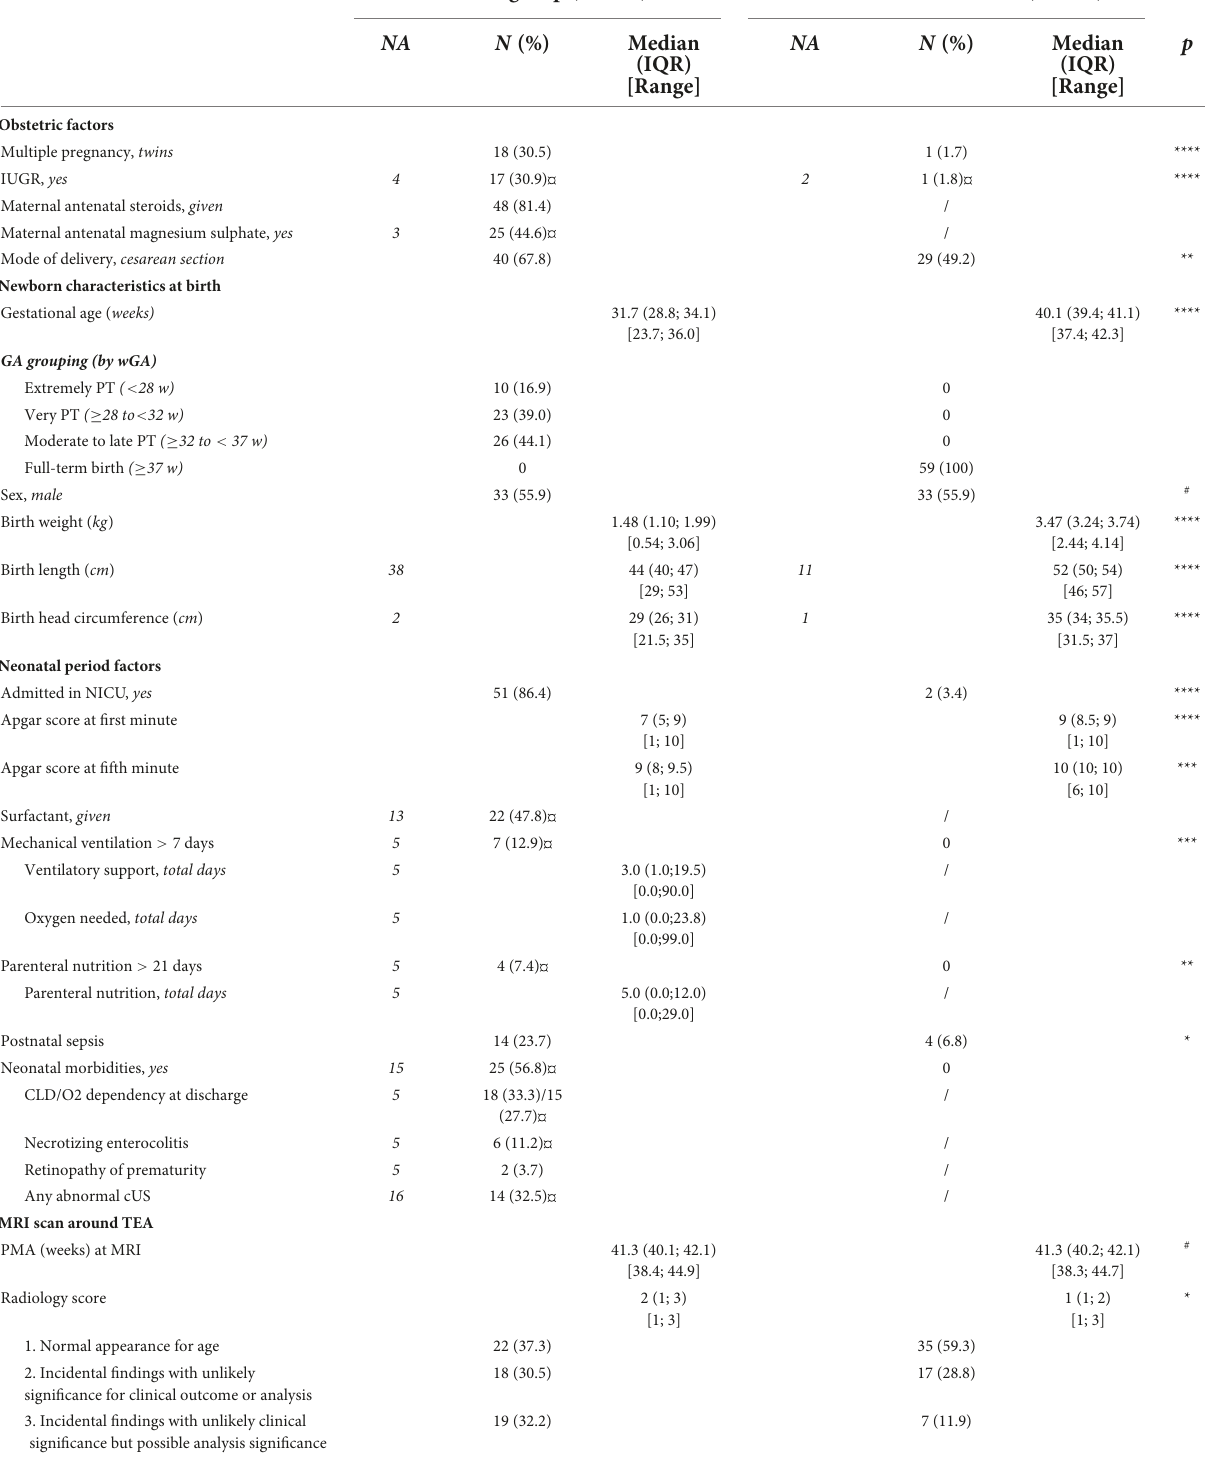
TABLE 1 Detailed clinical and sociodemographic information for the 59 pairs of infants. Preterm group ( N =